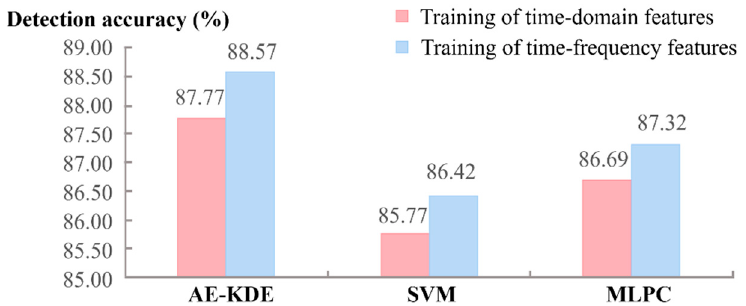
Figure 20. Detection accuracy of different anomaly detection methods.